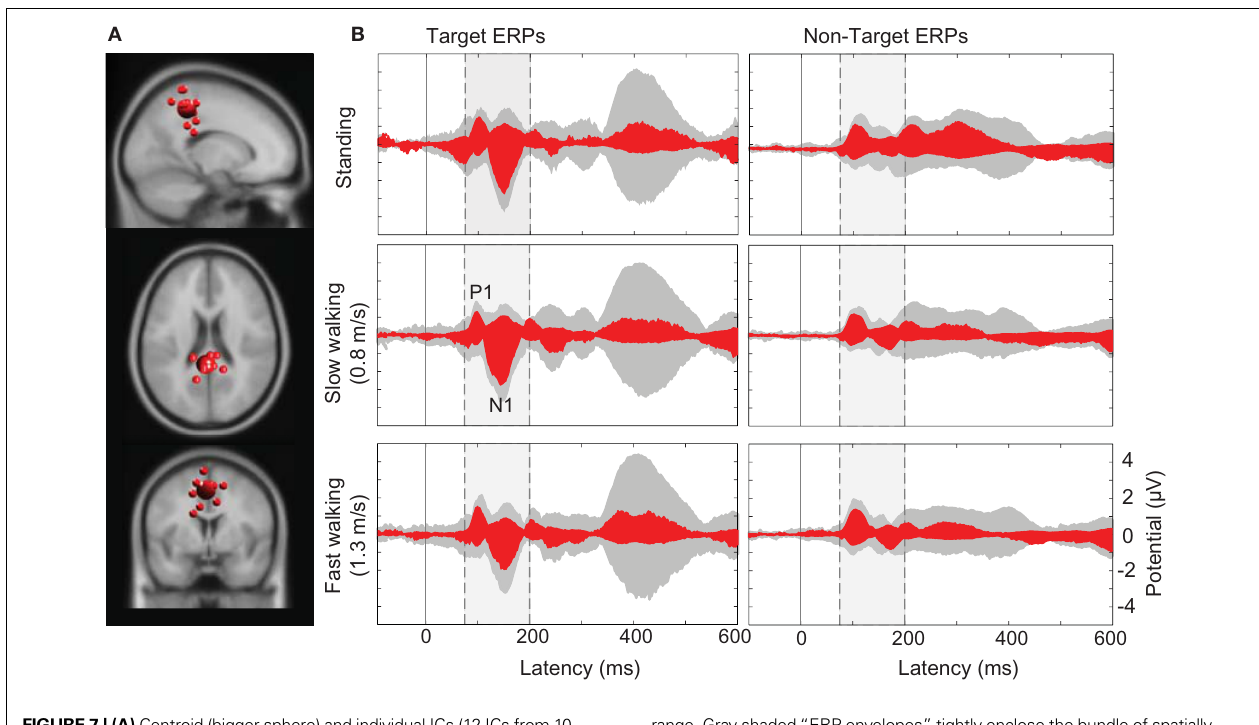
range. Gray-shaded “ERP envelopes” tightly enclose the bundle of spatially fi ltered scalp channel ERP traces at each latency. Red-fi lled envelopes outline